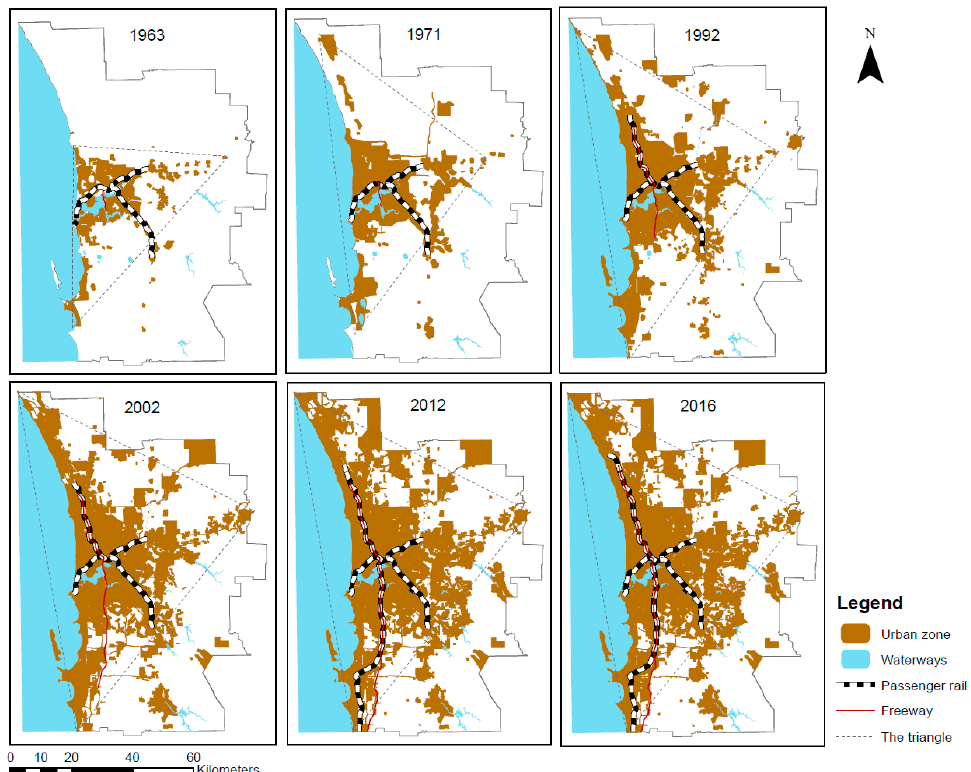
Figure 4. Metropolitan Region Scheme (MRS) urban land footprints changes between 1963 and 2016 (Note: Industrial and parks & recreation are also considered to be urban land). Source: Made by